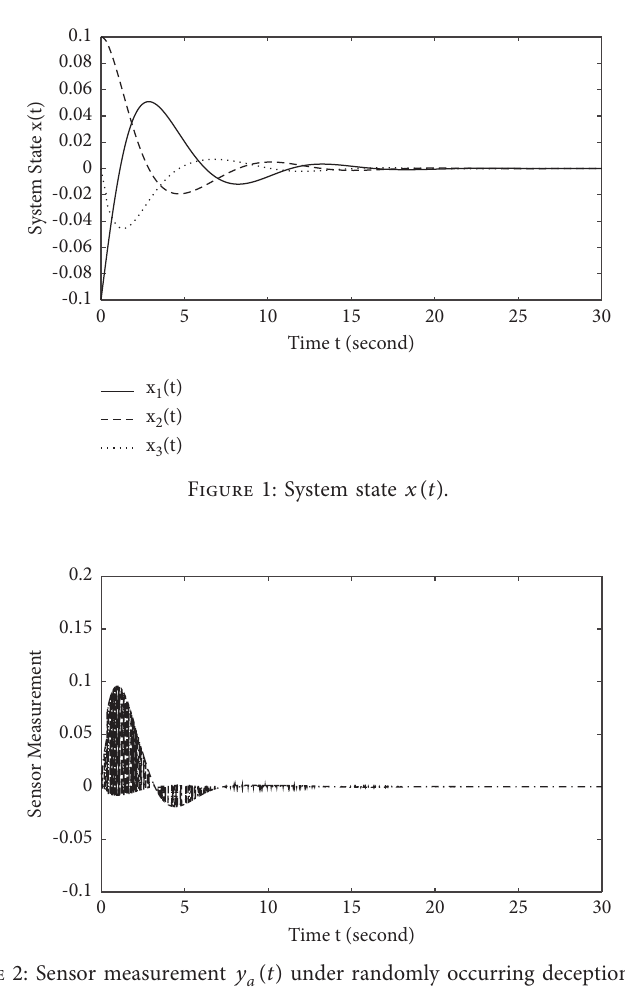
( t ) under randomly occurring deception attack. a